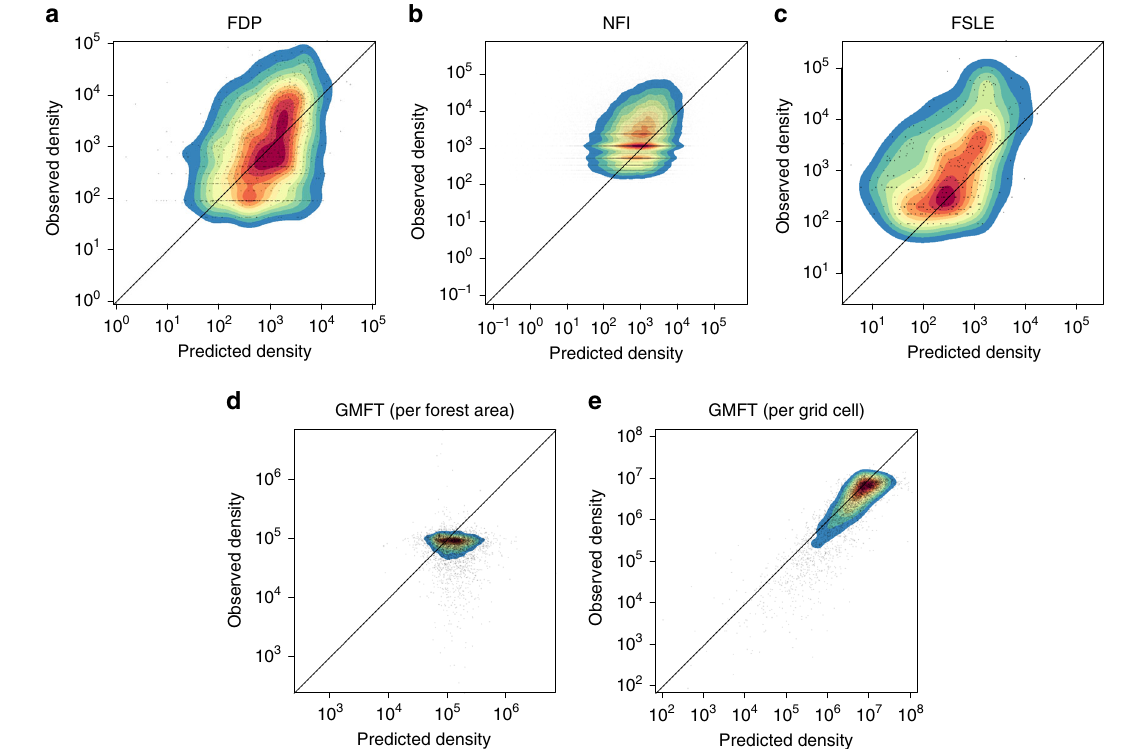
Fig. 3 Model prediction of individual density to validation data. a FDP, b NFI, c FSLE, d GMFT (per forest area) and e GMFT (per grid cell). Scatter diagrams, along with kernel density estimate, of the logarithms of individual density per 1 km 2 natural forest between the model prediction and the four validation datasets (FDP, NFI, FSLE, and GMFT). Reddish colours indicate higher density. The diagonal lines are the identity lines. For GMFT, in which individual density was validated at the scale of the 10-km grid cell, a scatter diagram based on individual density per grid cell is also shown in panel e . Coef fi cients of correlation are given in Table 1. The relationships are also shown on the arithmetic scale in Supplementary Fig. 8. Abbreviations: FDP – forest dynamics plots, NFI – National forest inventory, FSLE – forest sampling plots along latitudinal and elevational gradients, GMFT – global map of forest trees.